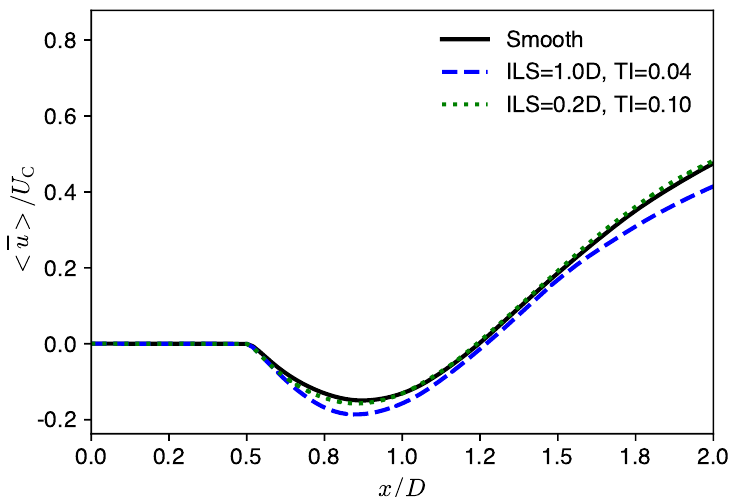
Figure 9. Time- and spanwise-averaged streamwise velocity on the central horizontal